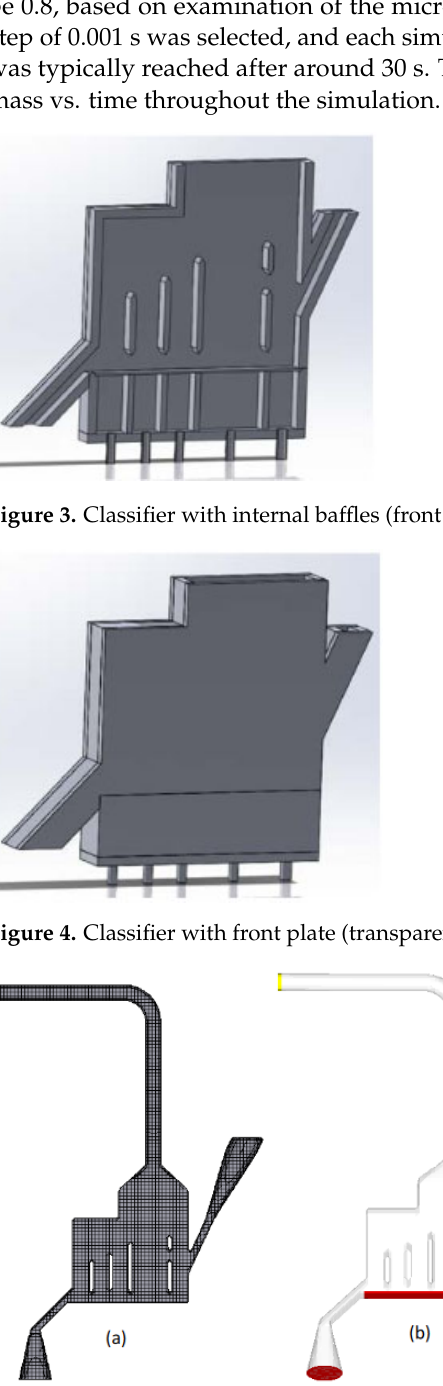
Figure 5. ( a ) Grid for the CFD simulations. ( b ) Boundary conditions of the geometry (yellow: pressure boundary conditions, red: flow boundary conditions).